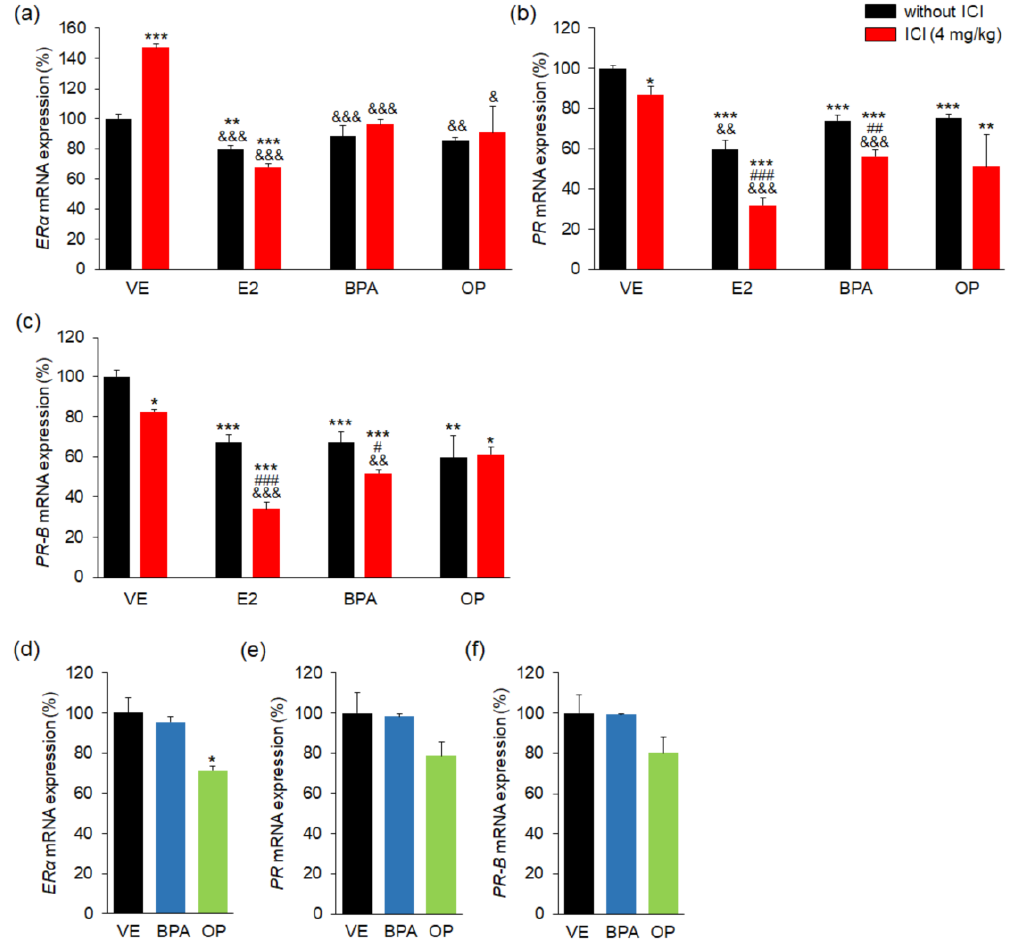
Figure 5. E2, BPA, and OP effects and estrogen and progesterone receptor expressions in maternal uterus and implantation sites. The expression levels of ER α , PR α , and PR β genes were measured by real-time PCR and normalized to that of 18S ribosomal RNA (RN18S). In uterus, ( a ) mRNA levels of ER were not changed by BPA or OP with/without ICI; ( b ) mRNA levels of PR were significantly low in all groups; ( c ) mRNA levels of PR-B were markedly low in all groups; In implantation sites, ( d – f ) the expressions of ER α mRNA were significantly decreased by OP. Statistical significance was determined by two-way ANOVA. * p < 0.05 vs. VE, ** p < 0.01 vs. VE, *** p < 0.001 vs. VE, # p < 0.05 EDs + ICI vs. EDs, ## p < 0.01 EDs + ICI vs. EDs, ### p < 0.001 EDs + ICI vs. EDs, & p < 0.05 vs. ICI, && p < 0.01 vs. ICI, &&& p < 0.001 vs. ICI. n = 5 mice per group for uterus, n = 3 mice per group for implantation sites. Treatments: E2; 40 µ g/kg/day, BPA; 100 mg/kg, OP; 100 mg/kg, ICI; 4 mg/kg.